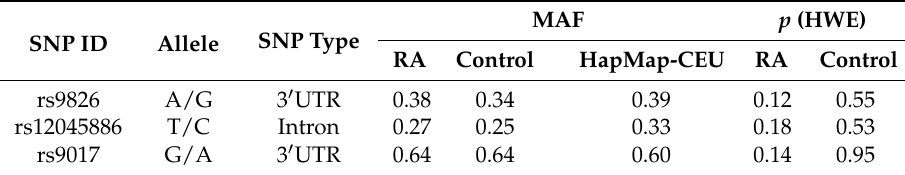
Table 1. SNPs information and genotyping results for rheumatoid arthritis (RA) patients and control